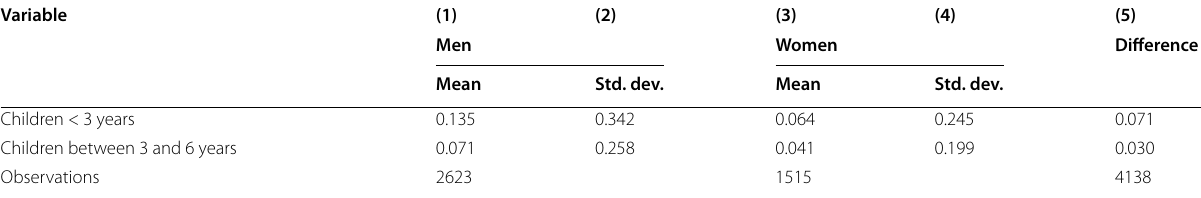
Table 2 Oaxaca–Blinder aggregate decomposition in 1984 and 2020 at the mean and selected percentiles